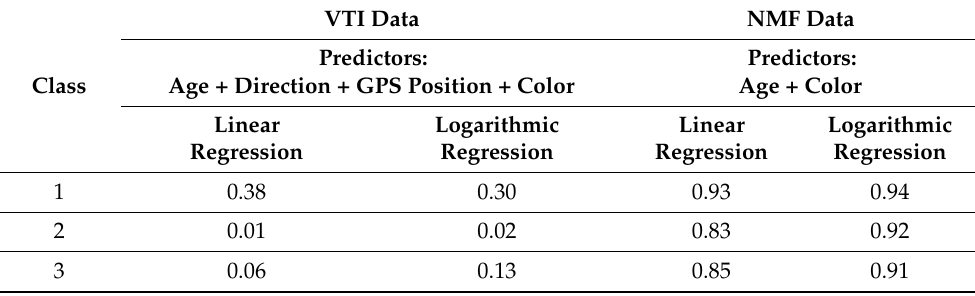
Table 8. R 2 values for VTI and NMF regression models for all